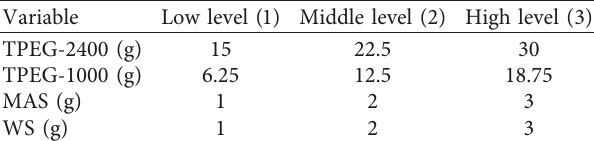
Table 2: Levels of variables used in the experimental design.